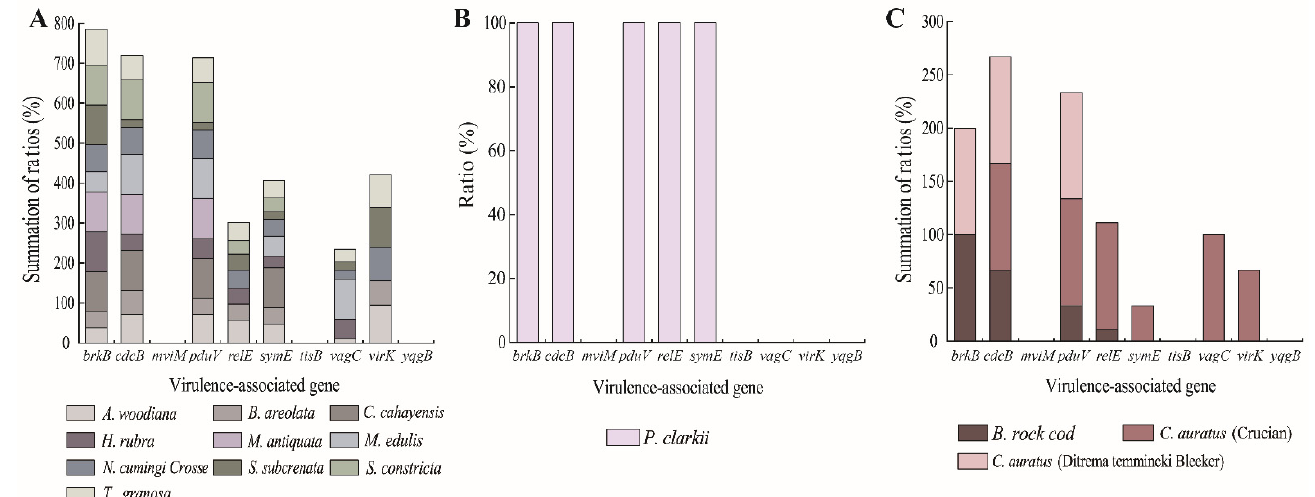
Figure 1. Virulence-related genes of the 125 K. oxytoca isolates recovered from 14 species of aquatic animals. ( A ) mollusks; ( B ) crustacean; ( C ) fish.